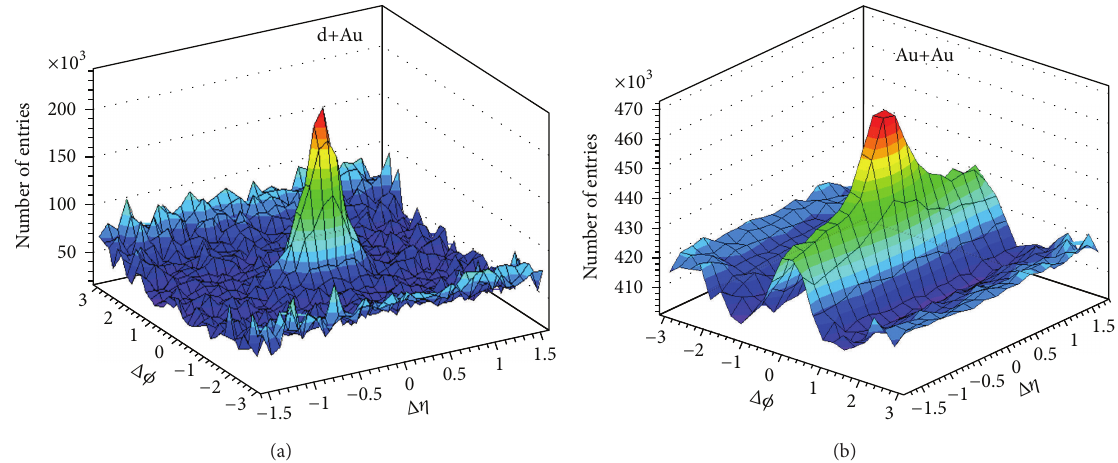
Figure 13: Two particle correlations in Δ𝜙 − Δ𝜂 in d+Au and Au+Au collisions are shown. The results are from STAR experiment.